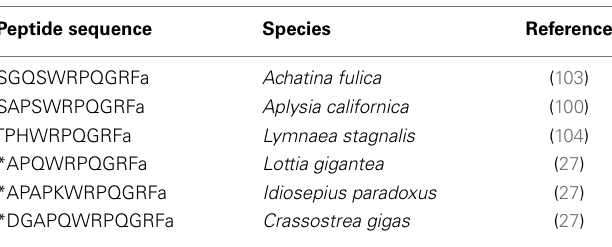
Table 4 | Luqin-like peptides